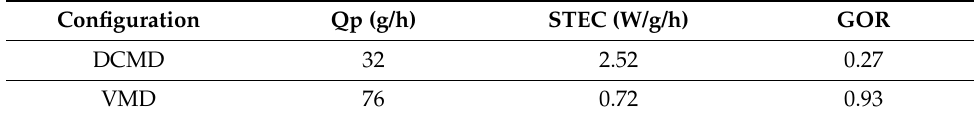
Figure 6. VMD flowsheet. Table 3. DCMD and VMD performances.